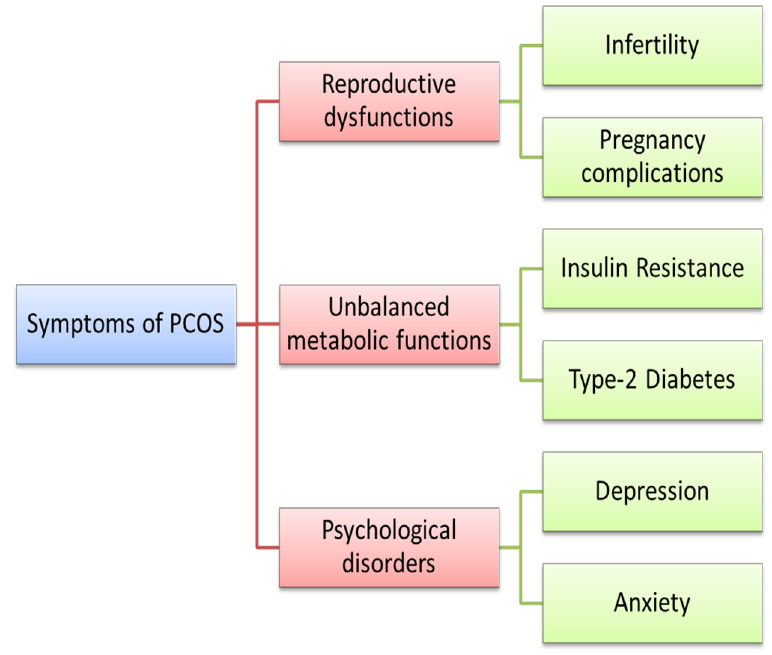
Figure 1. Major symptoms associated with polycystic ovarian syndrome (PCOS).